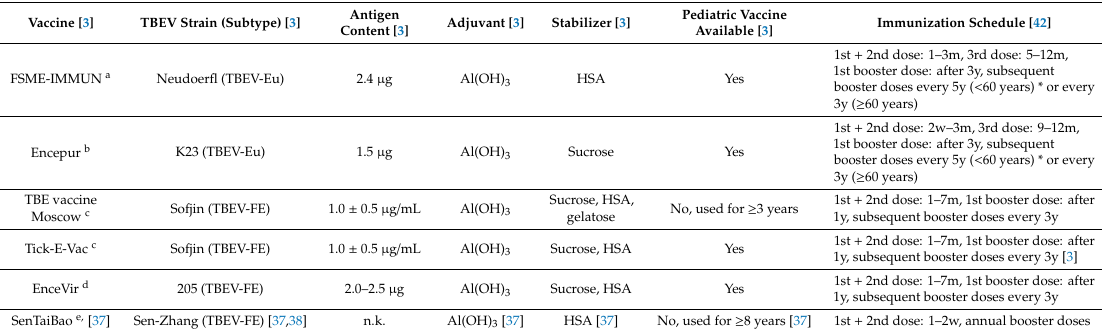
Table 1. Approved TBEV vaccines and immunization